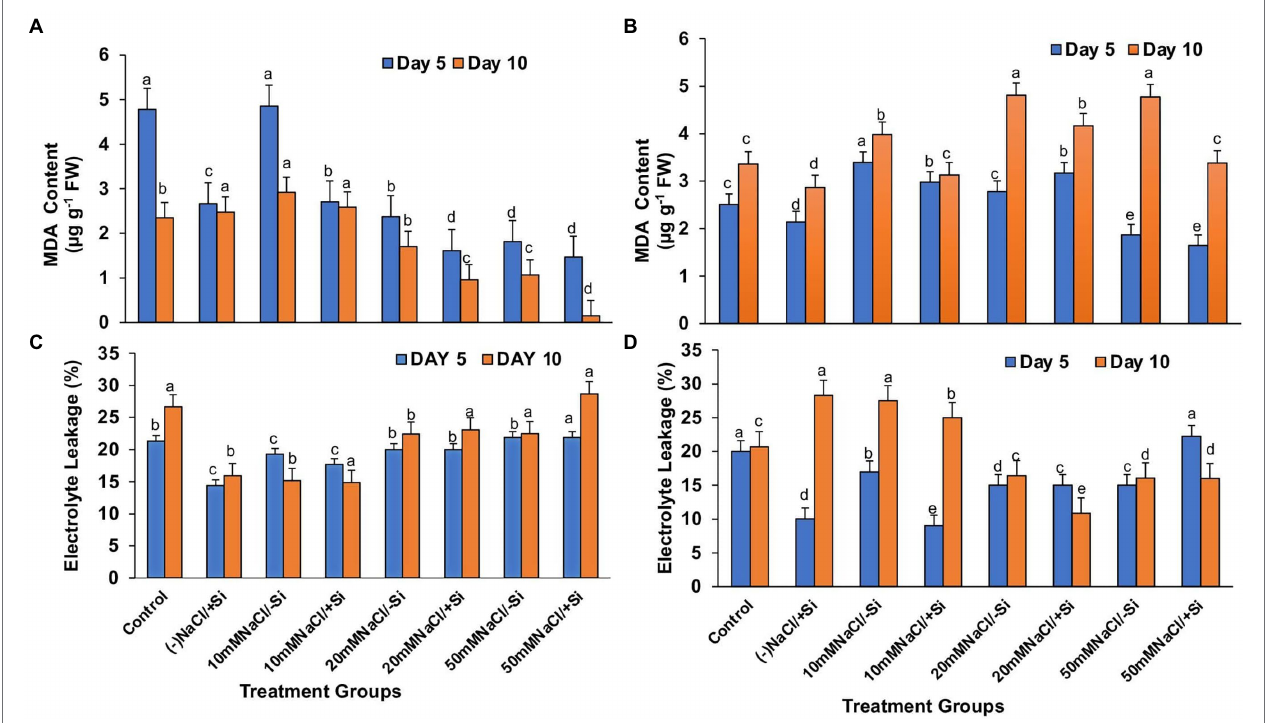
FIGURE 10 | Changes in (A,B) malondialdehyde content and (C,D) electrolyte leakage of mung bean ( Vigna radiata ) under 1 mM (Si 1 ) and 5 mM (Si 2 ) Si supply and salinity stress after eight treatments: (i) control (T1), (ii) − NaCl+Si (1 mM/5 mM) (T2), (iii) 10 mM NaCl/ − Si (T3), (iv) 10 mM NaCl/+Si (1 mM/5 mM) (T4), (v) 20 mM NaCl/ − Si (T5), (vi) 20 mM NaCl/+Si (1 mM/5 mM) (T6), (vii) 50 mM NaCl/ − Si (T7), and (viii) 50 mM NaCl/+Si (1 mM/5 mM) (T8) for a period of 5 and 10 days. Vertical bars indicate Mean ± SE of the means for n = 4. Means denoted by the different letters are significantly different at p ≤ 0.05 according to the Tukey’s studentized range